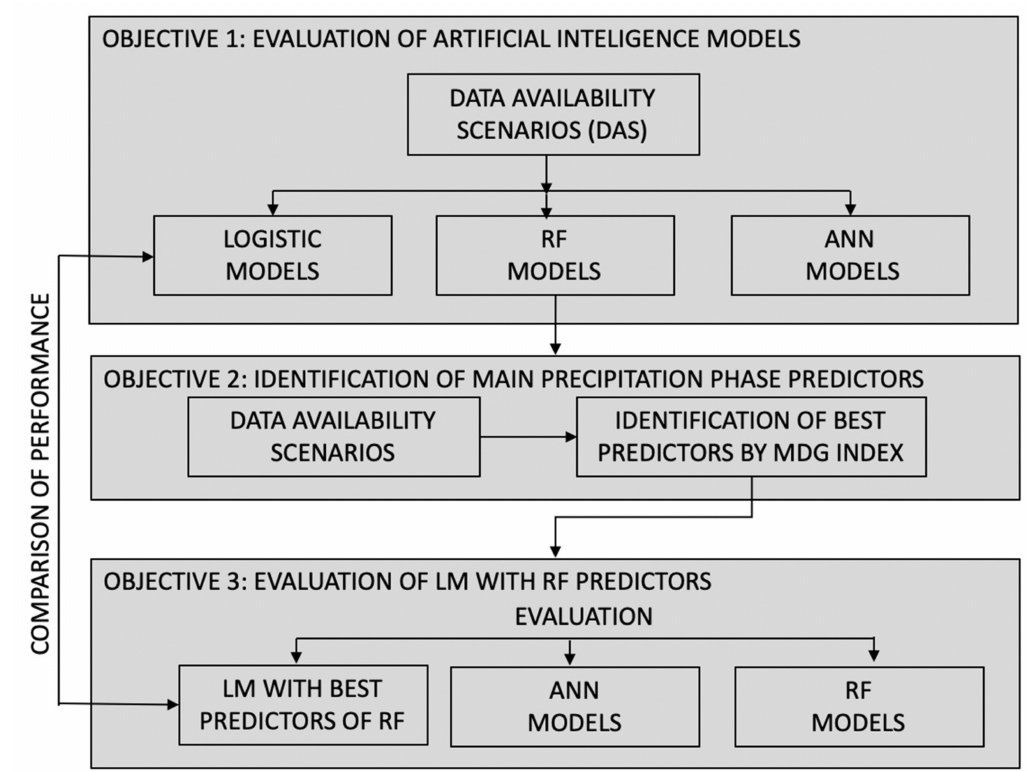
Figure 2. Flowchart of the